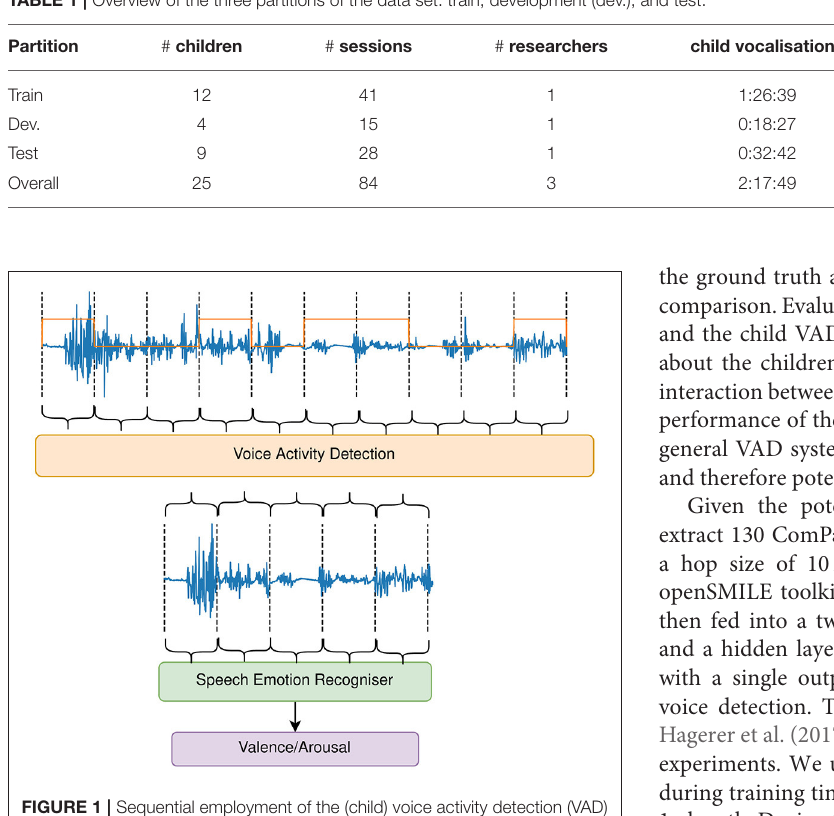
FIGURE 1 | Sequential employment of the (child) voice activity detection (VAD) and the speech emotion recognition (SER) system. The VAD system removes 1s chunks of the audio signal, where no voice is detected. Any remaining 1s chunks are fed into the SER system to predict continuous values for valence and